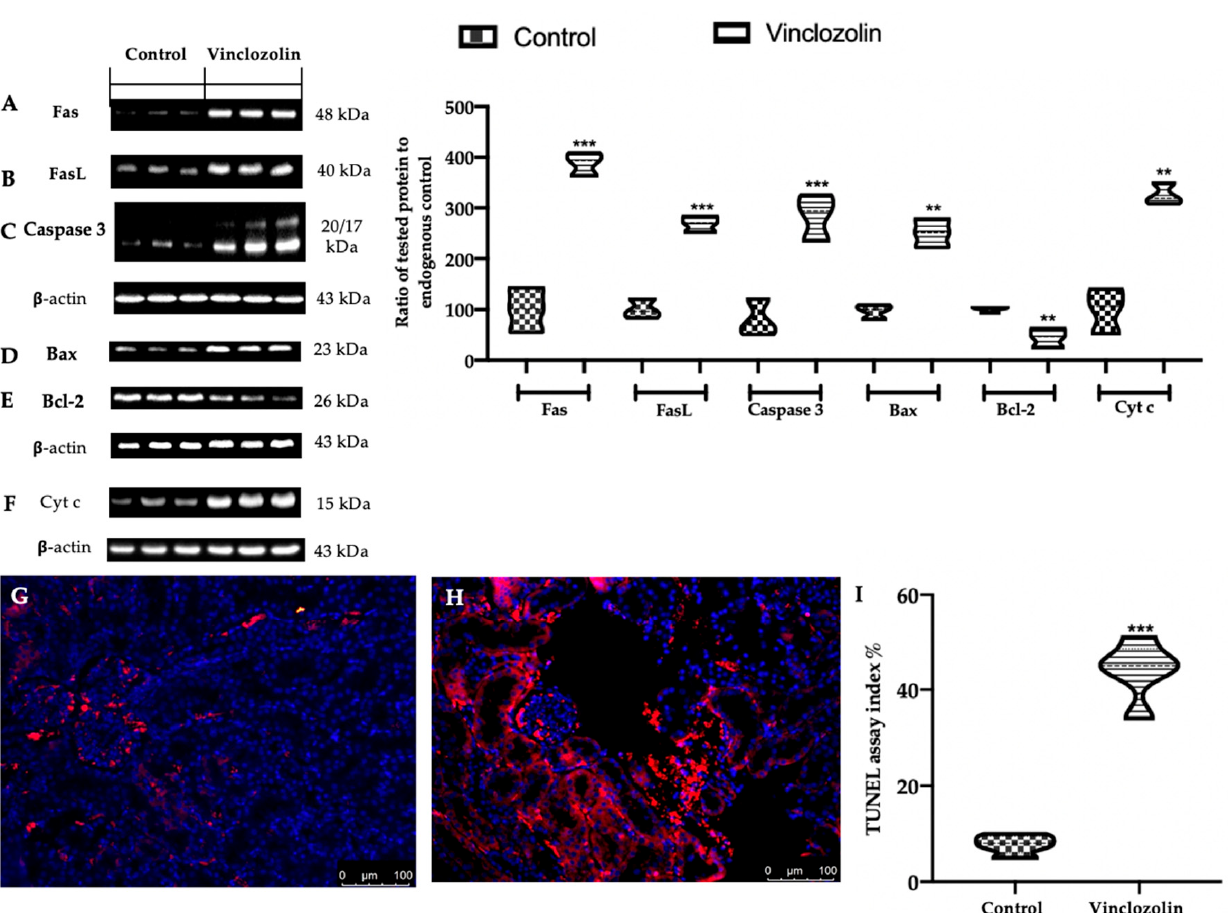
Figure 9. Effects of vinclozolin exposure on apoptosis: Western blot analysis of ( A ) Fas; ( B ) FasL; ( C ) Caspase 3; ( D ) Bax; ( E ) Bcl-2; ( F ) Cyt c expression, TUNEL-staining: ( G ) control; ( H ) vinclozolin; ( I ) TUNEL assay index %. Magnification 20 × .A p -value less than 0.05 was considered significant. ** p < 0.01 vs. control, *** p < 0.001 vs. control.